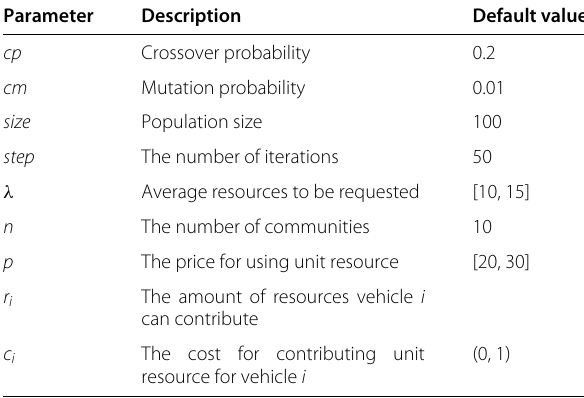
Table 1 Experimental parameter